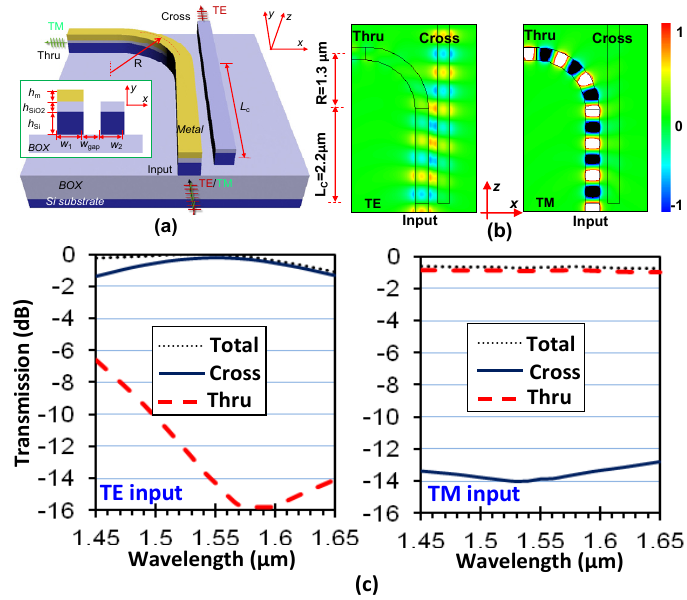
Figure 6. ( a ) Configuration of the ultrasmall PBS based on an ADC with a silicon hybrid nanoplasmonic waveguide; ( b ) Simulated light propagation for TE- and TM-polarizations; ( c ) Simulated transmission responses for TE- and TM-polarizations. The parameters are: L c = 2.2 μ m, R = 1.3 μ m, w 1 = 310 nm, w 2 = 280 nm, w gap = 200 nm, h Si = 230 nm, h SiO2 = 50 nm and h m = 100 nm [28].